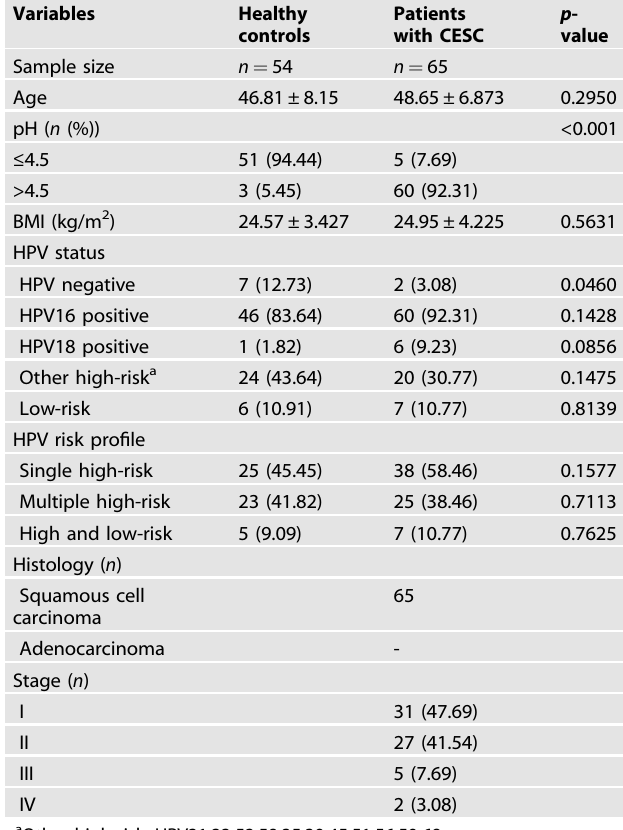
Table 1. Characteristics of the study